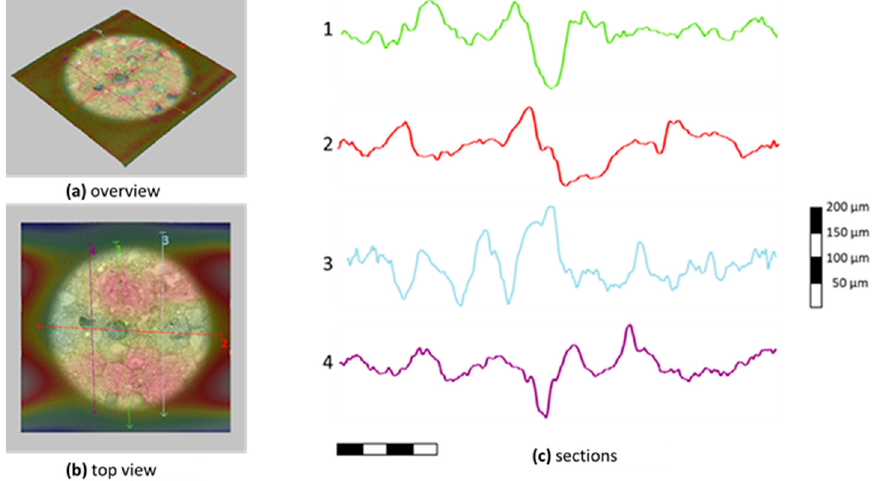
Figure 18. Microtopography of carbon fabric after failure in M60 composites.